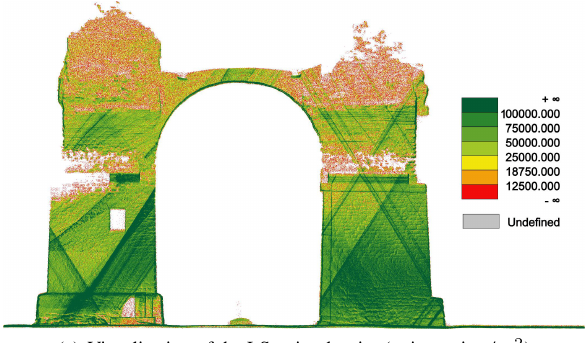
Figure 4: Histograms of the positional (units: meter) and angle (units: degree) differences between direct and indirect georefer- encing of the imagery.